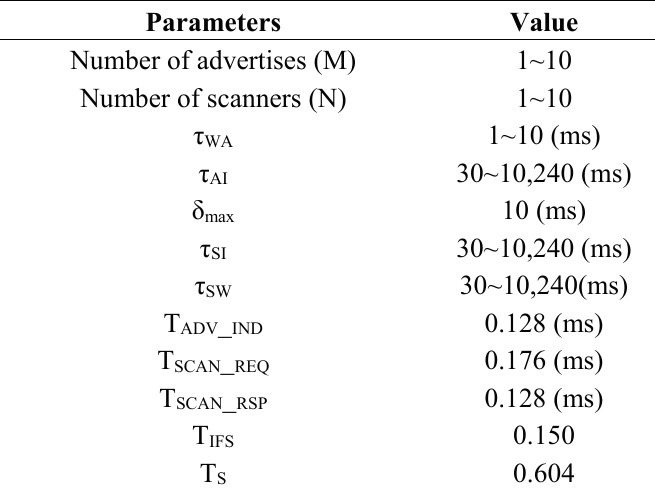
Table 4. Simulation parameters and their